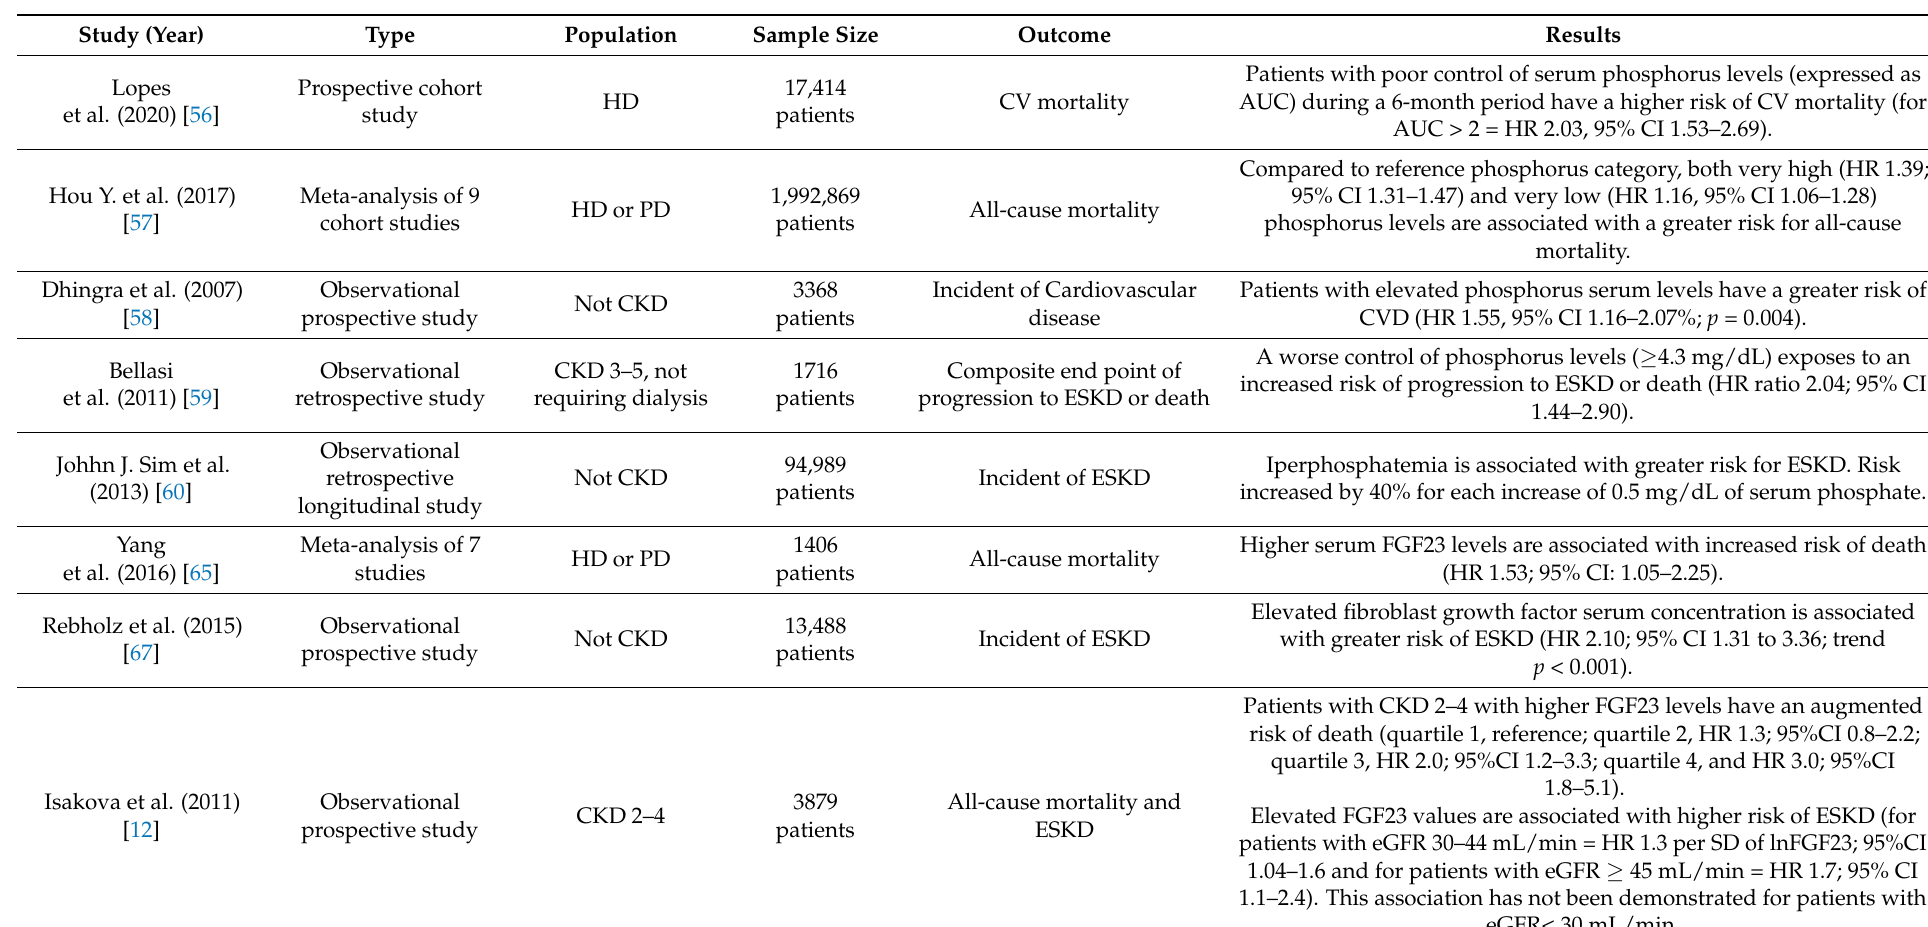
Table 1. Observational studies in MBD. CKD chronic kidney disease, CV cardiovascular, eGFR estimated glomerular filtration, ESKD end stage kidney